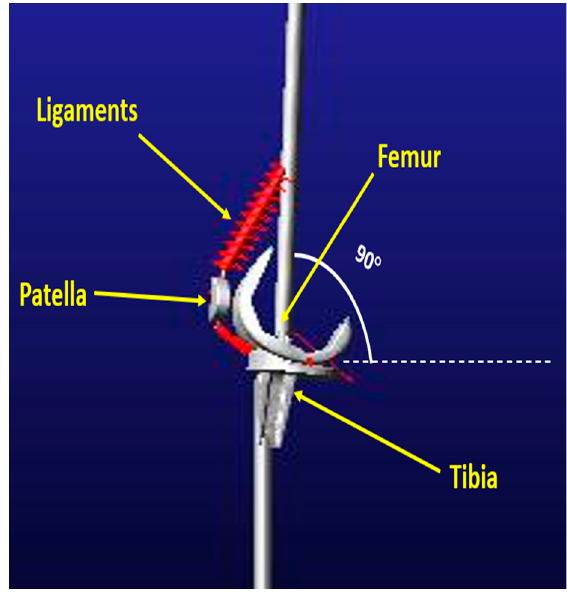
Figure 13. Multibody model at position 0°.